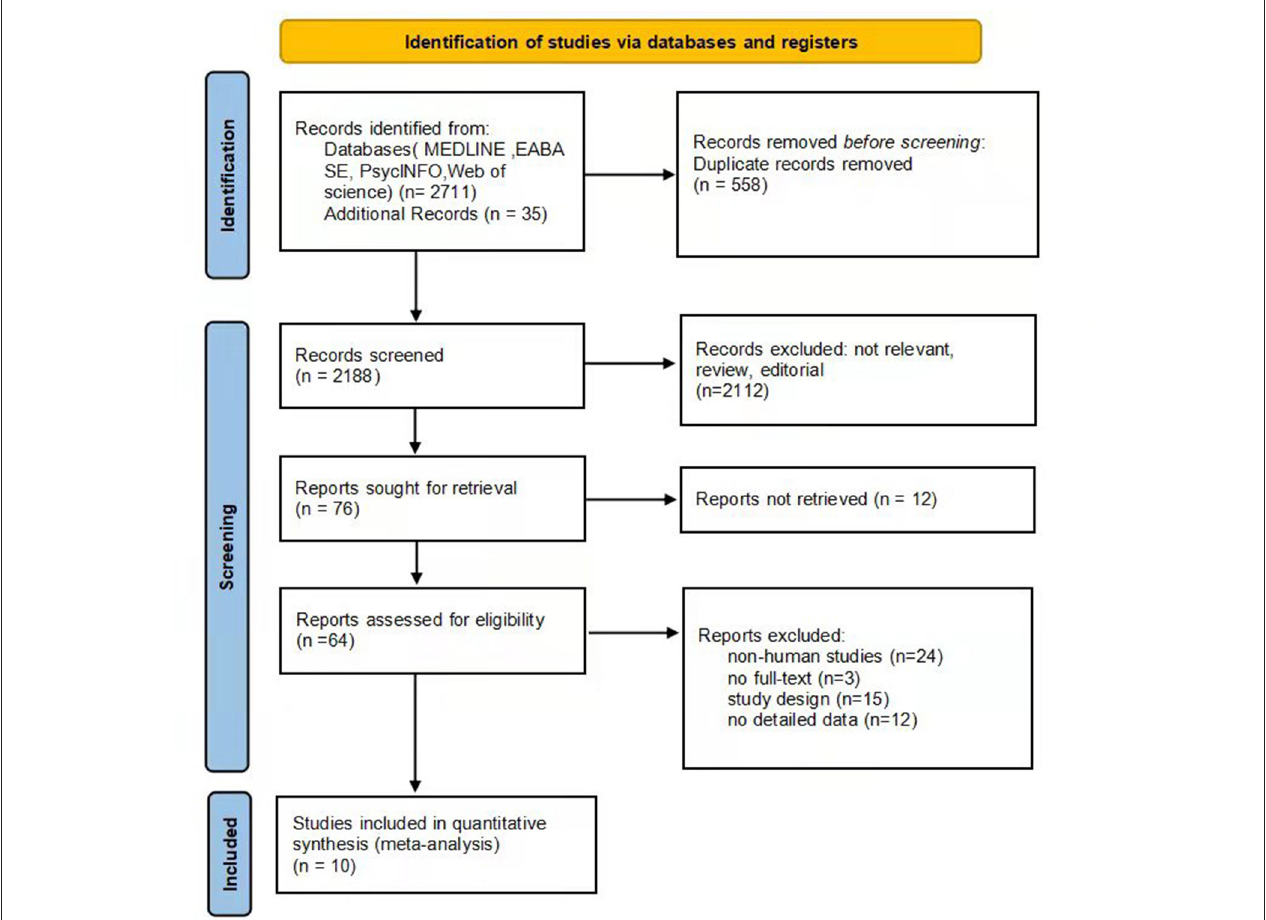
FIGURE 1 | Summary of the article extraction process, including the reasons for exclusion.